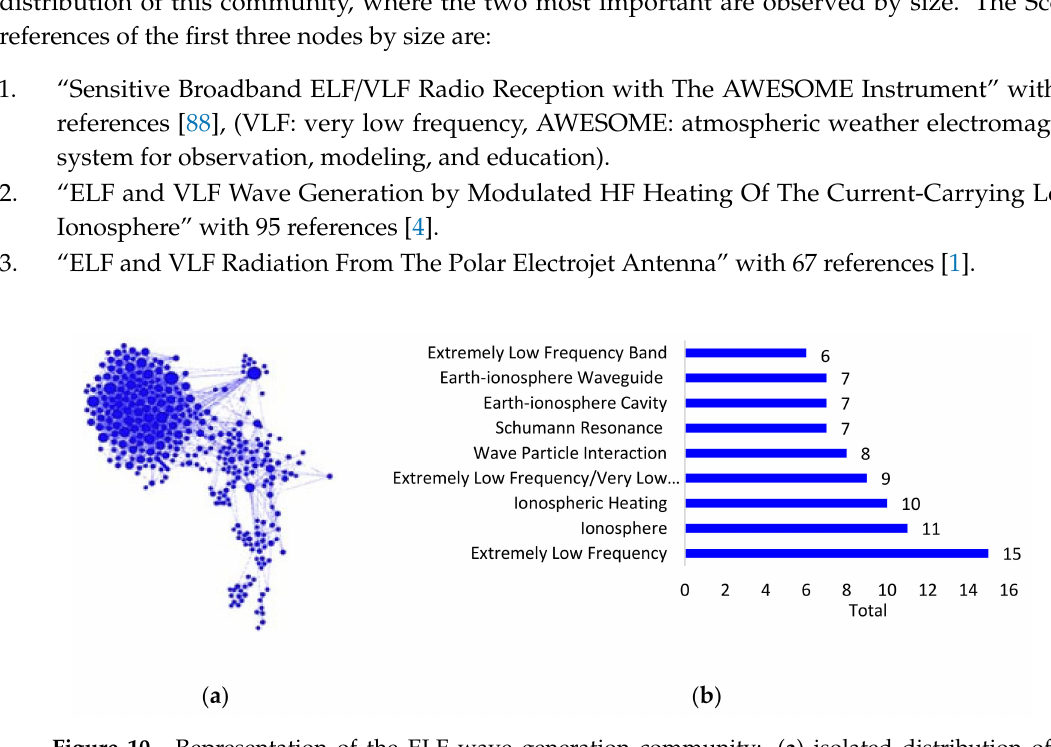
Figure 10. Representation of the ELF wave generation community: ( a ) isolated distribution of publications, ( b )